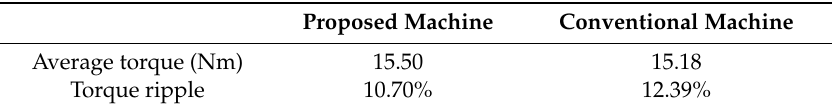
Table 4. On-load torque performance items.